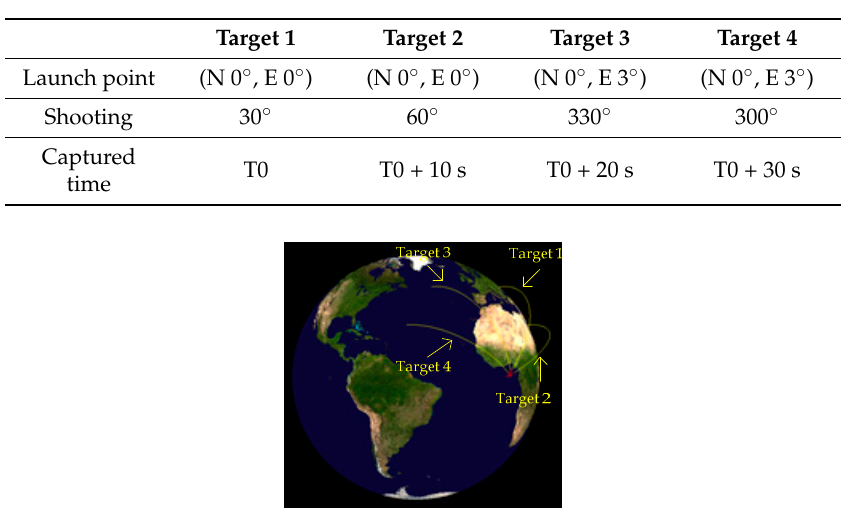
Figure 7. Trajectories (the red lines represent the boost phases of the ballistic missiles, and the yellow lines represent the free-flight phases.).